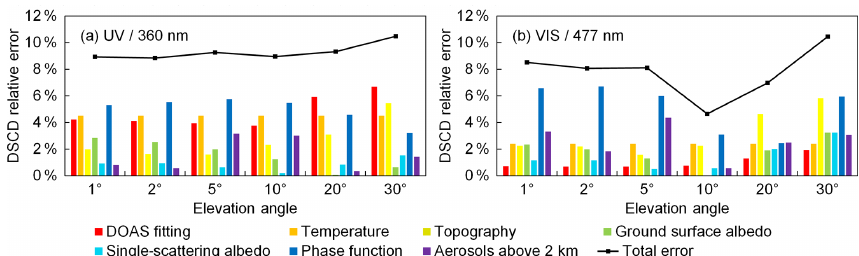
Figure 5. Error budget of (a) UV and (b) VIS bands of the scanning cycle on 5 July 2015 at ∼ 16:26UTC (SZA ∼ 64 ◦ , RAA ∼ 97 ◦ ). The y axes refer to the relative error of O 4 DSCDs.